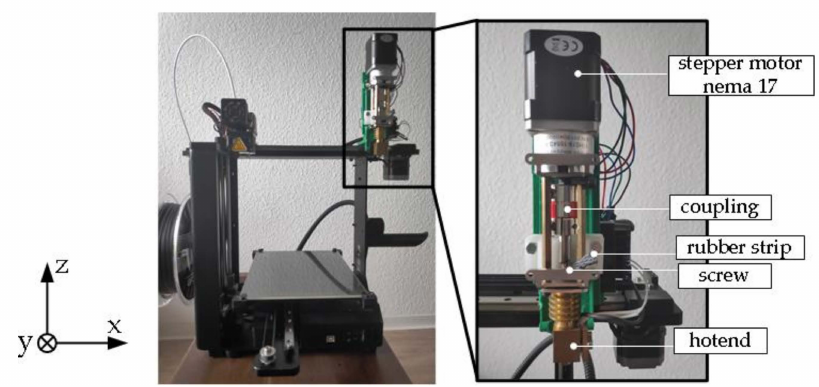
Figure 1. The MAKERGEAR M3-ID desktop 3D printer modified with a screw